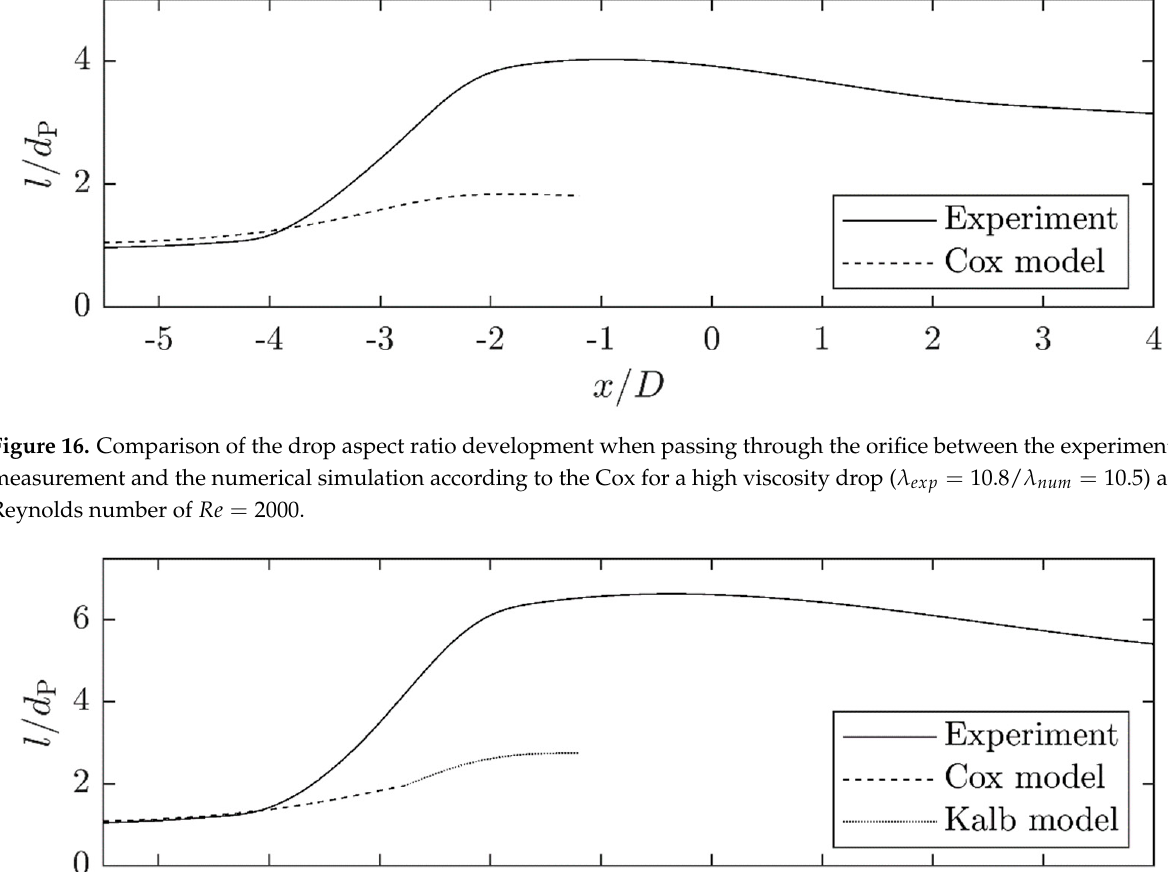
Figure 15. Comparison of the drop aspect ratio development when passing through the orifice be ‐ tween the experimental measurement and the numerical simulation according to the Cox or Kalb (cid:3404) 3.0 / 𝜆 (cid:3404) 3.09 ) at a Reynolds number of 𝑅𝑒 (cid:3404) 2000 . model for a medium viscosity drop ( 𝜆 (cid:3032)(cid:3051)(cid:3043) (cid:3041)(cid:3048)(cid:3040)